Question: Based on the figure, does the quantity rise or fall?
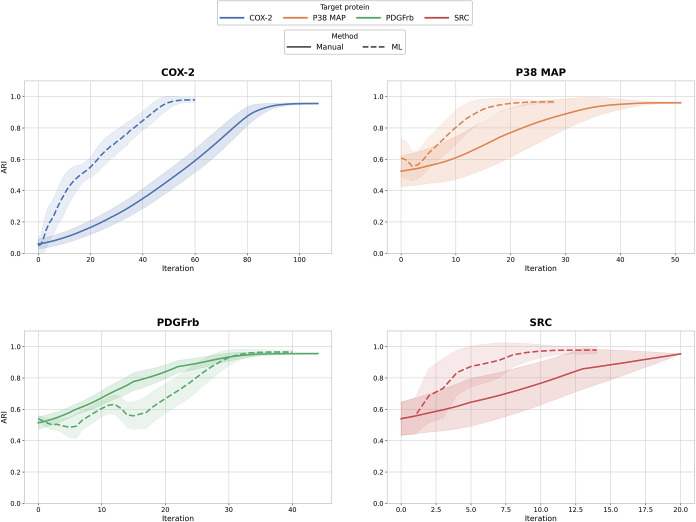
Answer: increasing